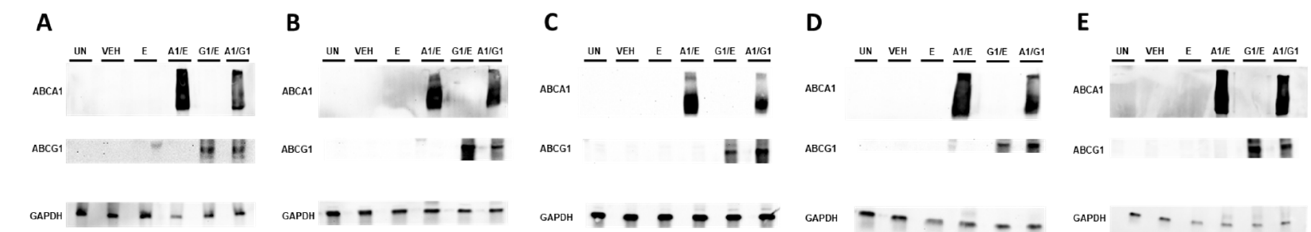
Figure 2. Robust ABCA1/ABCG1 protein expression is detected in 293-Cre cells transfected with ABCA1-LSL and ABCG1-LSL-based plasmids. ( A – E ) Cultured 293-Cre cells were either untreated (UN), vehicle-treated (VEH), transfected with empty vector plasmid (E), transfected with ABCA1- LSL plasmid and empty vector plasmid (A1/E), transfected with ABCG1-LSL plasmid and empty vector plasmid (G1/E), or transfected with ABCA1-LSL and ABCG1-LSL plasmids (A1/G1). Post- treatments, cell lysates were harvested 24 h ( A ), 36 h ( B ), 48 h ( C ), 60 h ( D ), or 72 h ( E ) after the respective treatments. ( A – E ) Immunoblotting was used to assess ABCA1, ABCG1, and GAPDH (loading control) protein expression in cell lysates.